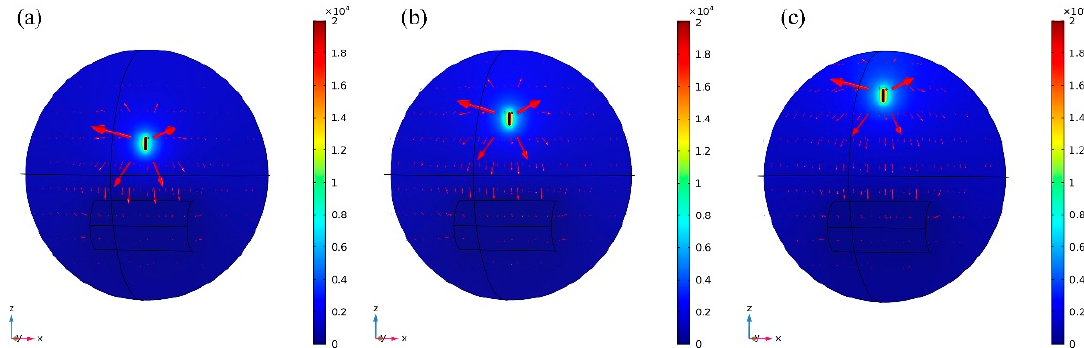
Figure 7. Electric field distribution at different receiving distances with voltage of 20 kV: ( a )100 mm, ( b ) 150 mm, and ( c ) 200 mm.